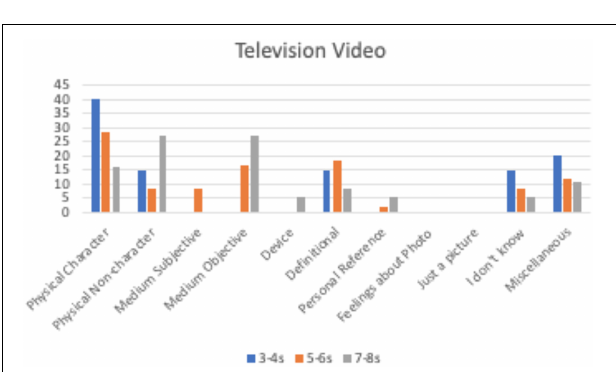
FIGURE 5 | Percentage of children by age group providing each justification for the television video.